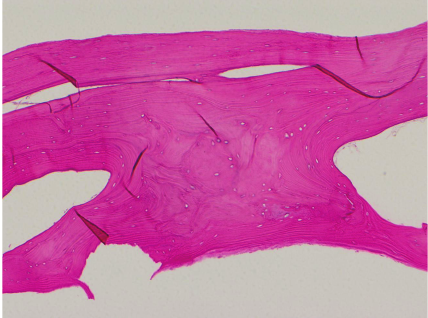
Figure 2: Histopathology of heterotopic ossification illustrating normal, mature lamellar